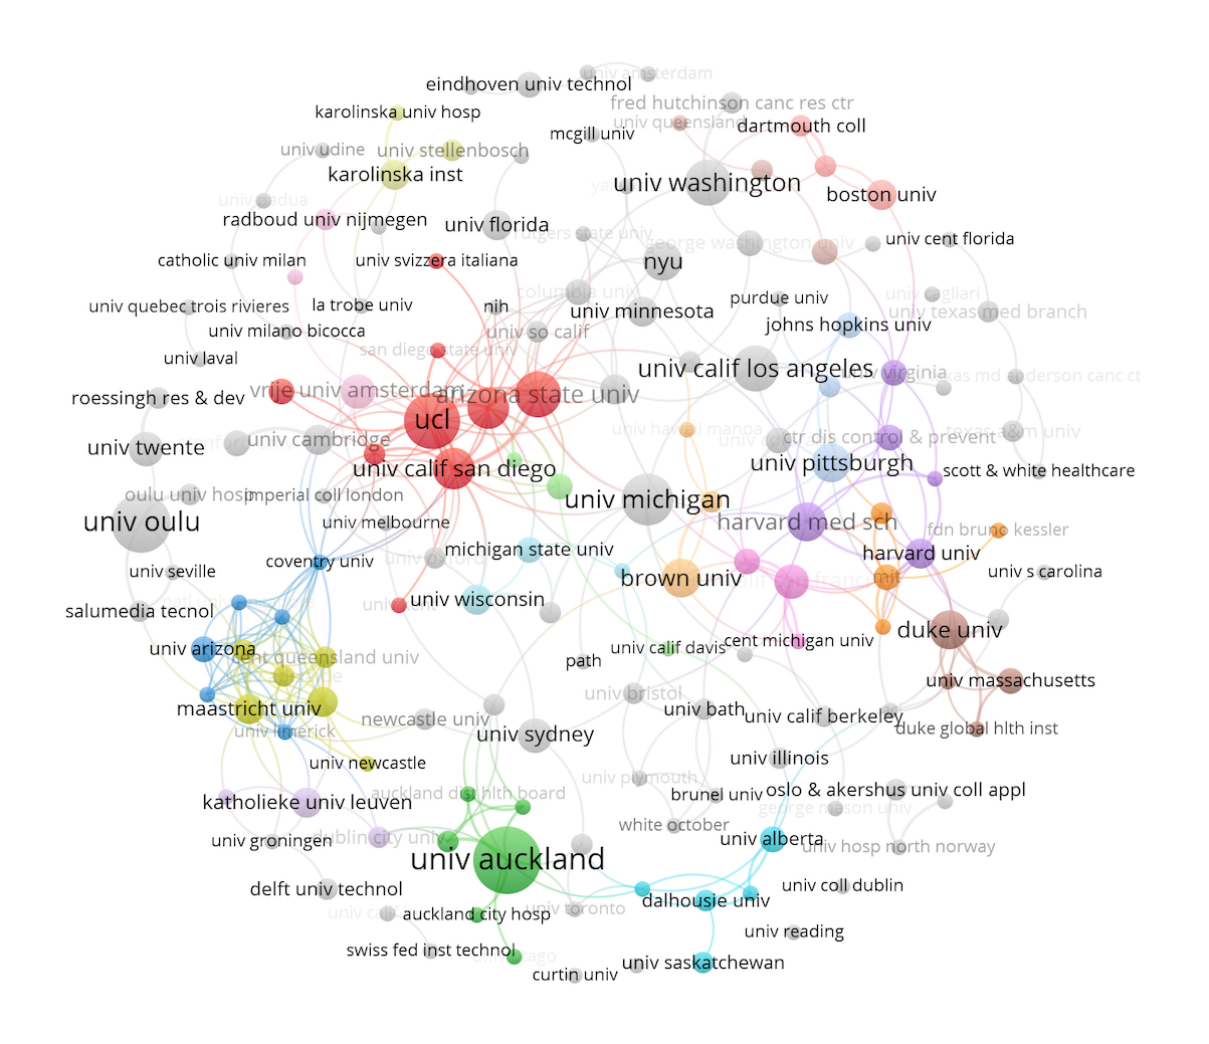
Figure 7. Organization/institution collaboration graph. Coll: college; Hosp: hospital; Inst: Institute; NYU: New York University; Technol: